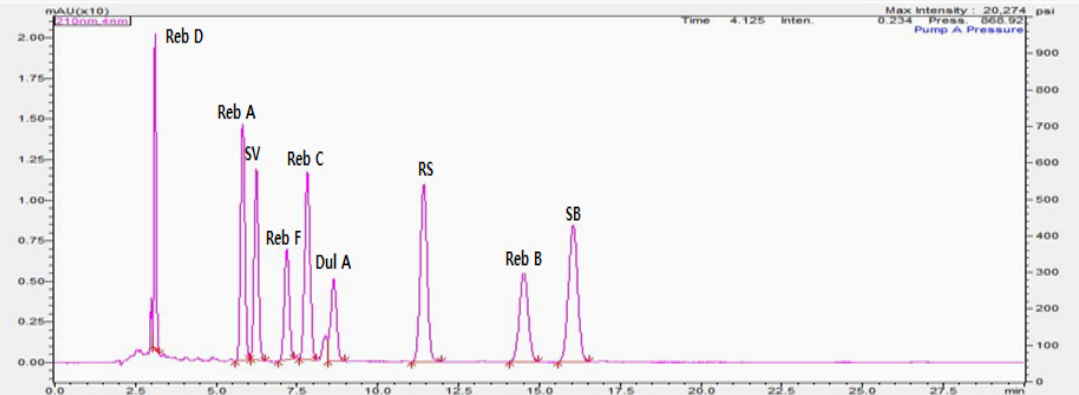
Figure 3. Chromatographic profile of steviol glycoside standards. Rebaudioside D (Reb D), rebaudioside A (Reb A), stevioside (SV), rebaudioside F (Reb F), rebaudioside C (Reb C), dulcoside A (Dul A), rubusoside (RS), rebaudioside B (Reb B), and steviobioside (SB).